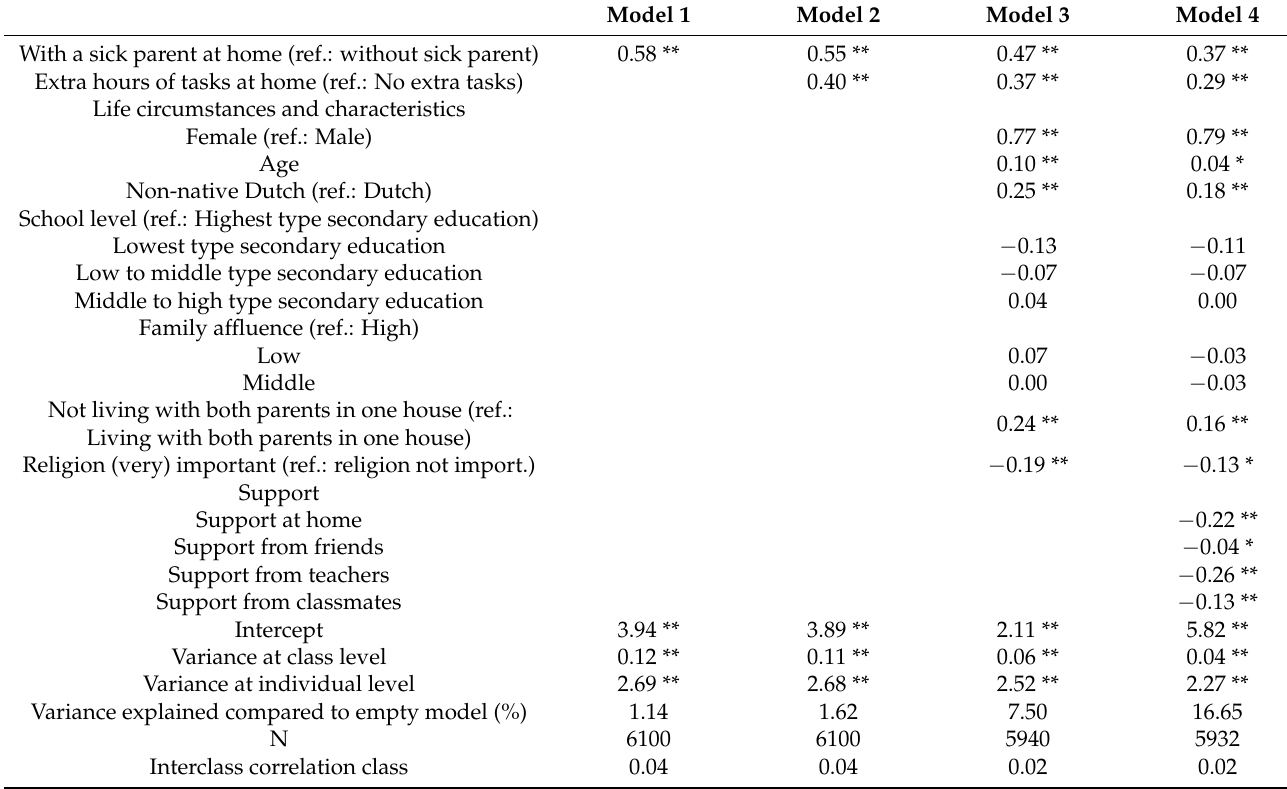
Table 2. Stepwise multilevel regression of having a chronically sick parent at home, extra task hours at home, life circumstances and characteristics, and social support on psychosomatic complaints (scale) of schoolchildren aged between 12 and 16 (unstandardised coefficients, n =